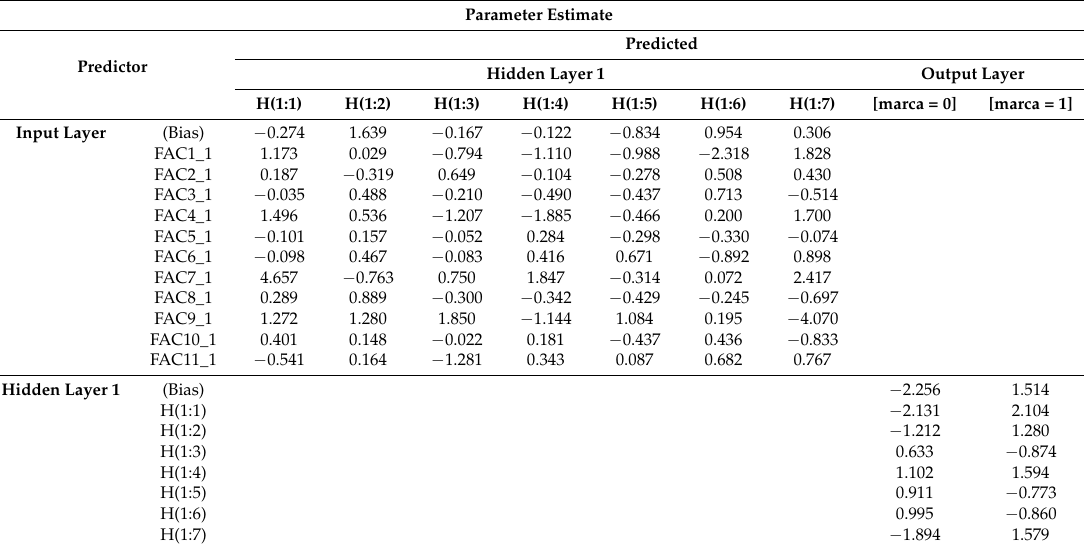
Table 3. Estimations of the neural network model for tax